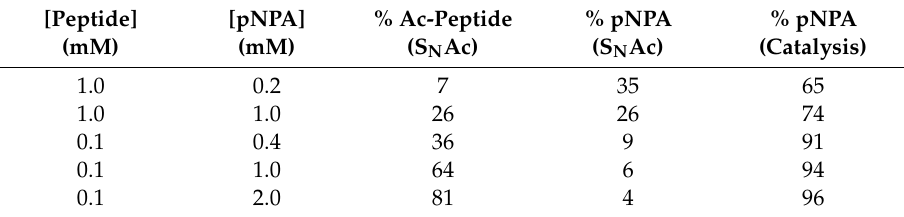
Table 3. LC–MS analysis to verify the extent of amine-mediated acetylation